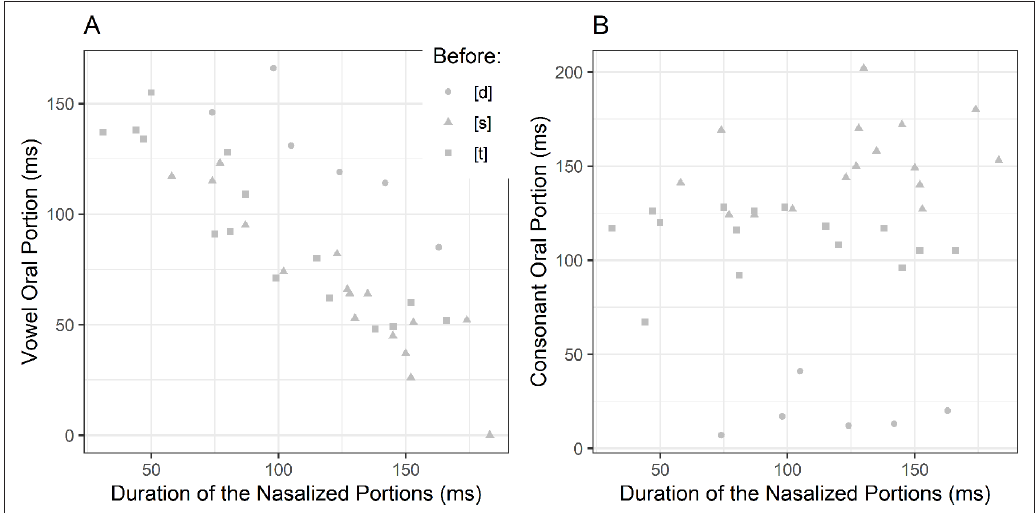
Figure 10: Participant L1: Vowel oral portion (A) and consonant oral portion (B) as a function of the duration of the nasalized portions.